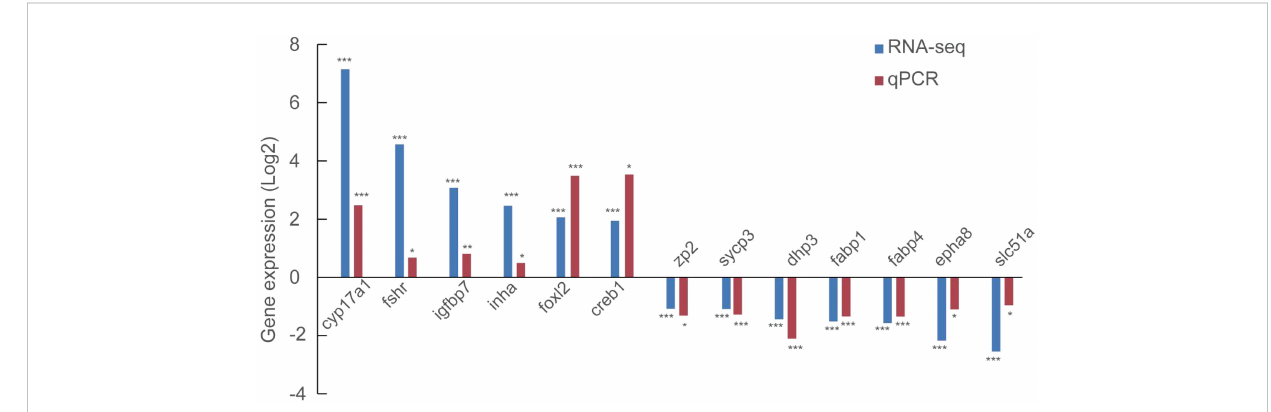
FIGURE 3 Validation of the expression of 6 up-regulated and 7 down-regulated using qRT-PCR. *, P<0.05; **, P<0.01; ***,